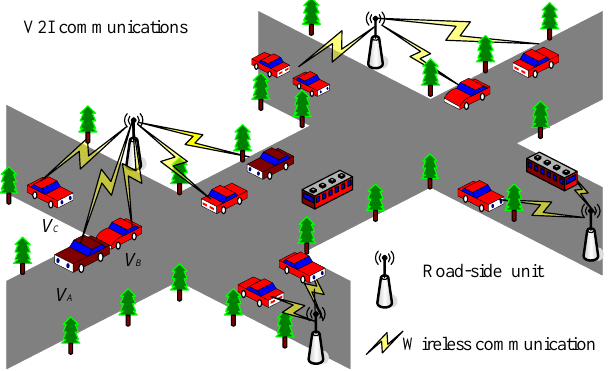
Figure 2. Communication scenarios of our many-to-one and one-to-many schemes.